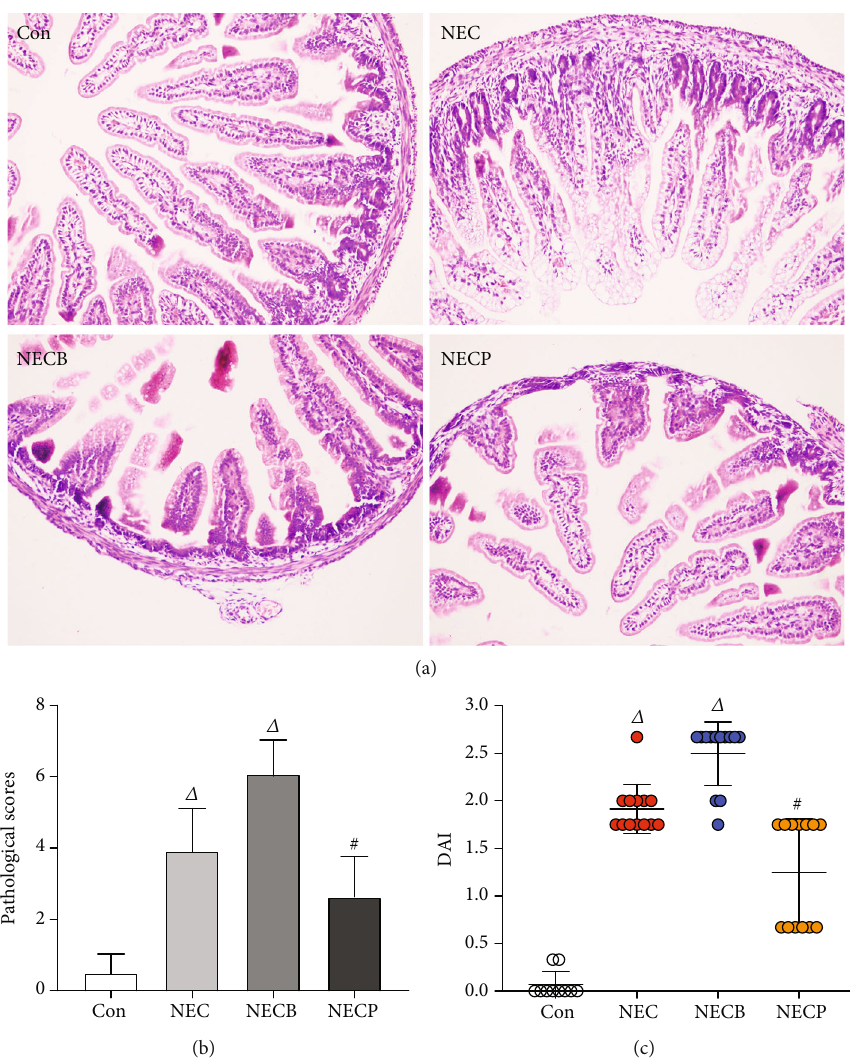
Figure 3: Inhibition of A R by PSB1115 attenuated NEC. (a) H&E staining (200x) of intestinal tissues showed improved morphology in the 2B NECP group as compared with the NEC and NECB groups; (b) pathological scores in the NECP group were signi fi cantly lower than that in the NEC and NECB groups; (c) the disease severity of NEC was determined by the DAI score. Animals in the NECP group showed lower DAI scores than those in the NEC and NECB groups. DAI: disease activity index; NEC: necrotizing enterocolitis; NECB: necrotizing enterocolitis +BAY60-6583 treatment; NECP: necrotizing enterocolitis+PSB1115 treatment. Δ p < 0 : 05 vs. all other groups; # p < 0 : 01 vs. the Con